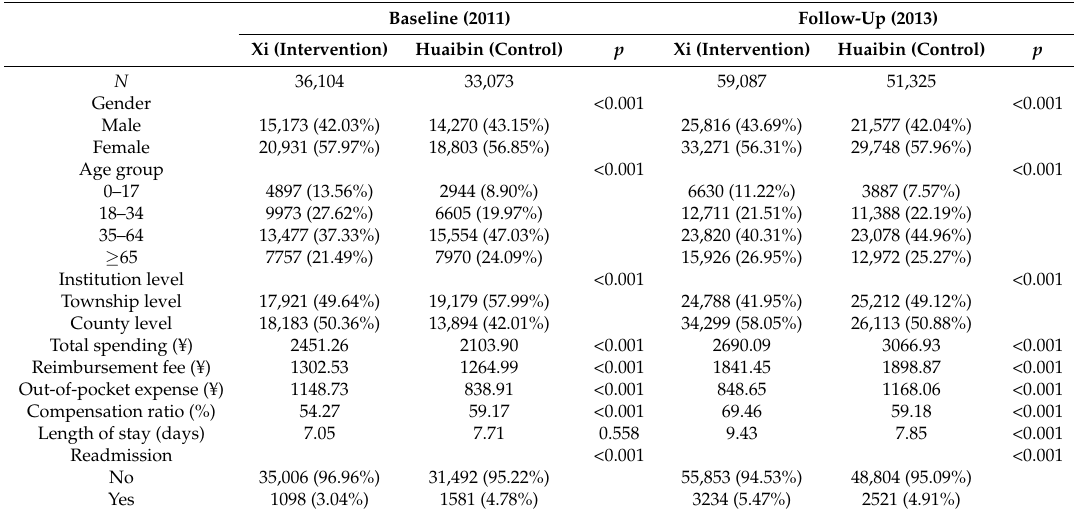
Table 2. Basic characteristics of inpatients in Xi and Huaibin Counties, 2011 and